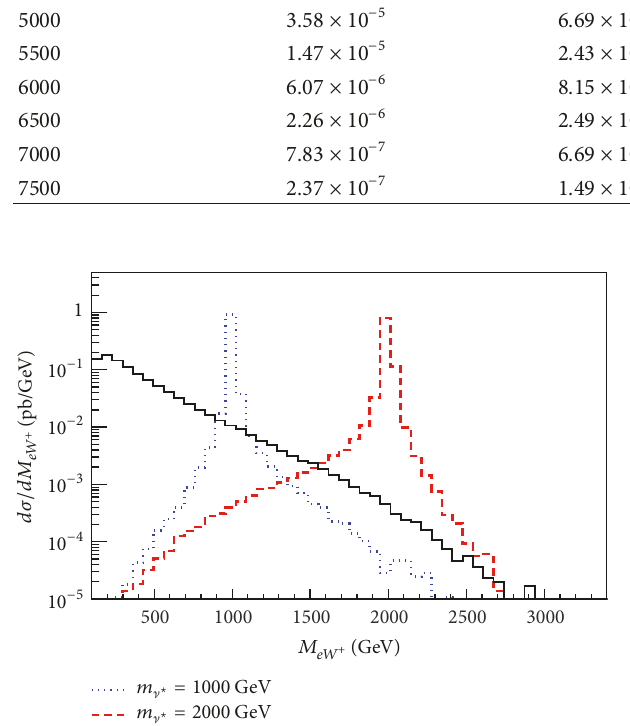
Figure 5: The invariant mass distributions of the excited neutrino signal and the corresponding background for Λ = 𝑚 ] ⋆ and 𝑓 = 𝑓 󸀠 = 1 at the ERL 60 ⊗ FCC collider.